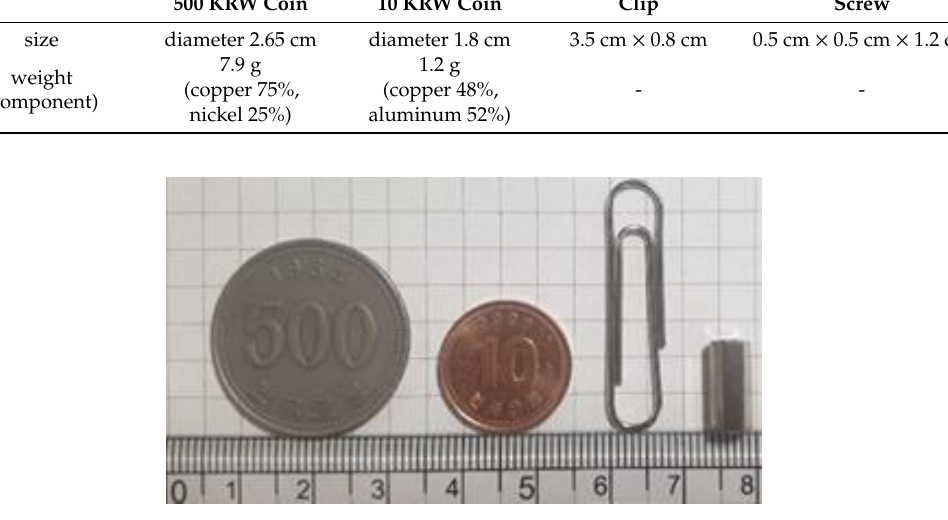
Table 1. Comparison of metal foreign objects used in the experiment.